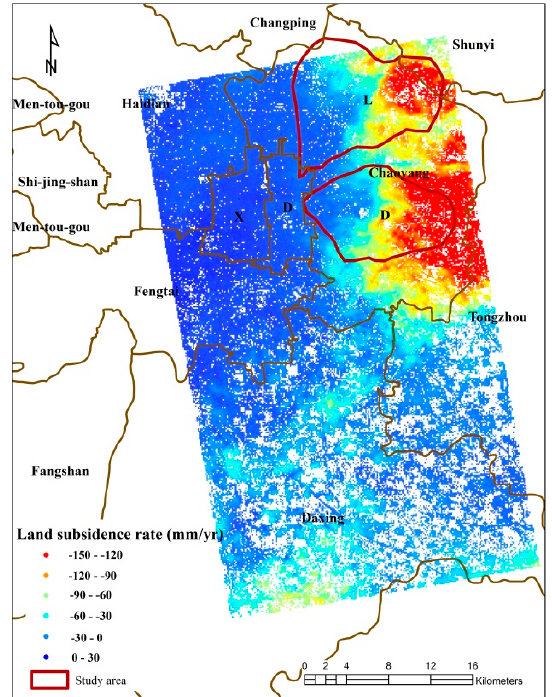
Figure 3. Mean land subsidence rate based on the TerraSAR-X data from 2011 to 2015. The red lines are the study area boundary. L and D are the Laiguangying and DongbalizhuangDajiaoting land subsidence areas, respectively.